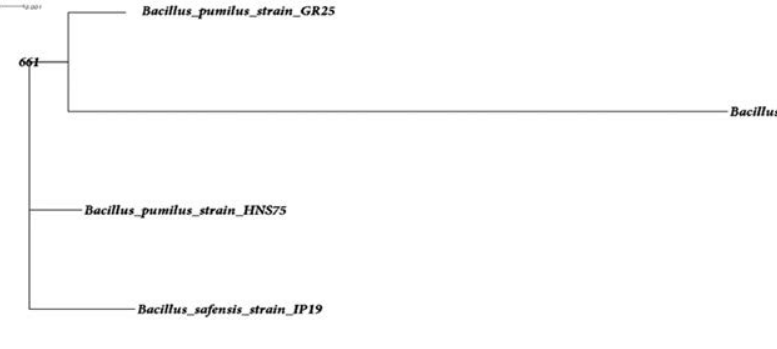
Fig. 1. Phylogenetic tree of UC H1